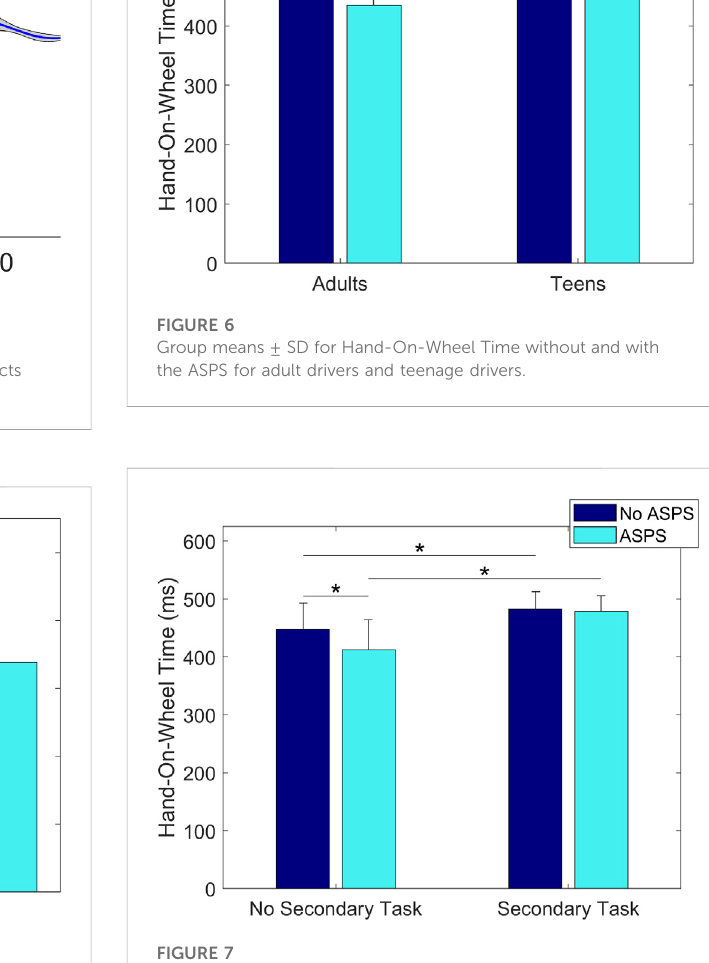
Group means ± standard deviation (SD) for Hand-Lift-Off Time without and with the ASPS.